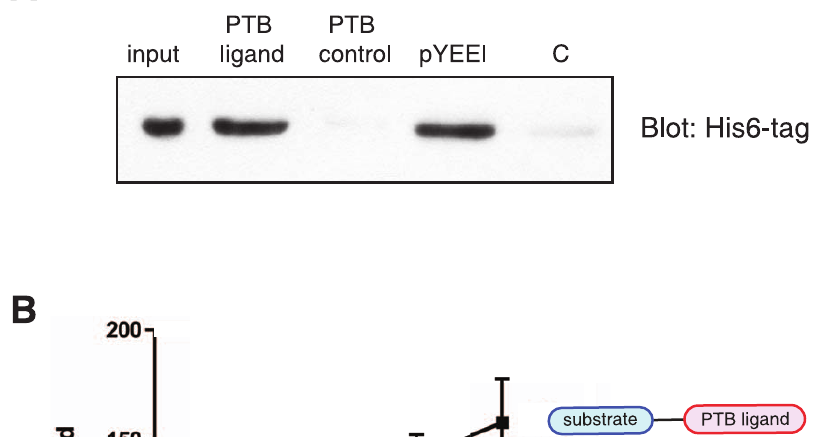
Figure 5. Substrate targeting by PTB ligand. (A) Purified HMTK1 (6.6 m g) was incubated with PTB ligand-containing substrate (KKAEEEIYGEFEANFTNPVpYATLG), PTB control substrate (KKAEEEIYGEFEANFTNPVFATLG), pYEEI peptide, or control resin in final volumes of 60 m l. After washing, bound proteins were eluted with SDS-PAGE sample buffer and analyzed by Western blotting with anti-His 6 -tag antibody. (B) The kinase activity of HMTK1 (300 nM) toward the PTB ligand-containing substrate or PTB control substrate (shown schematically) was determined using the phosphocellulose paper assay. The reaction contained 20 mM Tris-HCl (pH 7.4), 10 mM MgCl 2 , 0.2 mM ATP, 30 m M peptide, and [ c - 32 P]-ATP. At each time point, an aliquot was withdrawn and 10% trichloroacetic acid was added to stop the reaction. Incorporation of 32 P into the peptides was determined by scintillation counting. doi:10.1371/journal.pone.0019296.g005 Figure S2 Autophosphorylation of HMTK1. Purified HMTK1 (36 ng) was analyzed by anti-pTyr Western blotting after incubation with Yersinia tyrosine phosphatase ( + YOP), with no treatment (HMTK), or after an autophosphorylation reaction ( + ATP). The autophosphorylation reaction contained 1 mM ATP and 10 mM MgCl 2 , and proceeded for 45 minutes at 30 u C. (EPS) Figure S3 Structural model of HMTK1 PTB. A homology model of the third PTB domain of HMTK is shown, based on the human Numb-R protein [30]. We identified Numb-R as the closest relative to the third PTB domain of HMTK using HMM- HMM comparisons (http://toolkit.tuebingen.mpg.de/hhpred). Numb-R contains two Phe residues that are important for ligand binding [31], and the two Phe residues are conserved at equivalent positions (F71 and F117) in the HMTK PTB domain. Figure S1 Sequence alignment of the kinase domains of (EPS) HMTK1 and human fibroblast growth factor receptor 1. The HRD/HMD sequences in the catalytic loop are underlined, Figure S4 Expression of HMTK1 in mammalian cells. and the tyrosine residue in the predicted activation loop is shown (A). SYF cells were transfected with FLAG-tagged HMTK1 (wild- in red. type, D PTB, or mutant forms, as indicated). Whole cell lysates were analyzed by SDS-PAGE and Western blotting with anti-